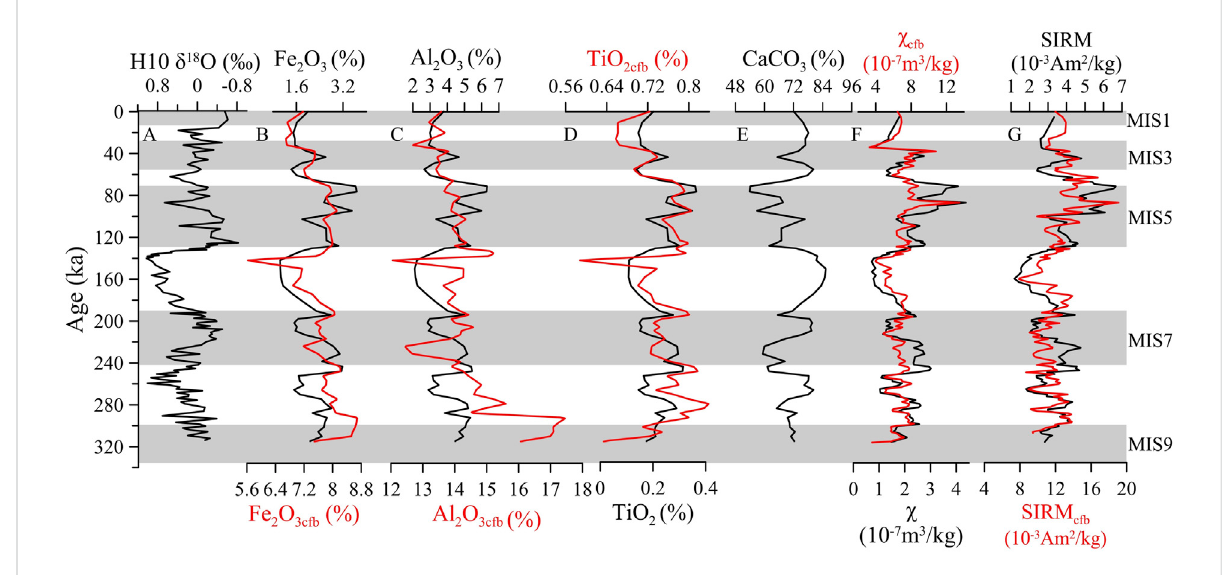
FIGURE 3 (A) Pro fi les of the δ 18 O; (B) Fe 2 O 3 concentration and carbonate-free basis Fe 2 O 3 (Fe 2 O 3cfb ); (C) Al 2 O 3 concentration and carbonate-free basis